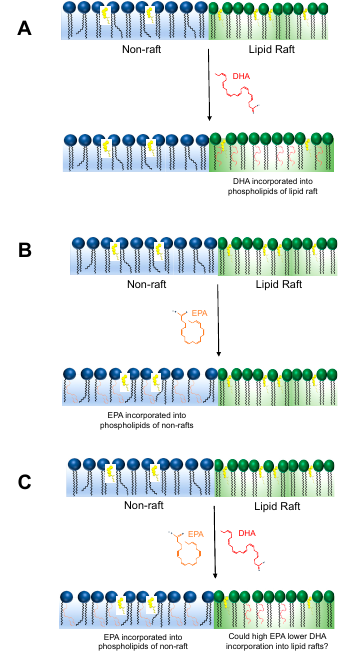
Figure 1. EPA (eicosapentaenoic acid) and DHA (docosahexaenoic acid) exert differential effects on lipid rafts in some cell types. ( A ) DHA can directly infiltrate lipid rafts to modify their biophysical organization whereas ( B ) EPA largely avoids interactions within lipid rafts and prefers the disordered non-raft region. ( C ) DHA incorporation and disruption of lipid raft size and stability may be influenced by the availability of EPA in the membrane, which is an area for future investigation.